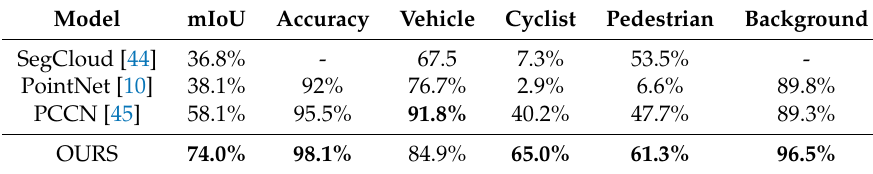
Table 6. Segmentation results on